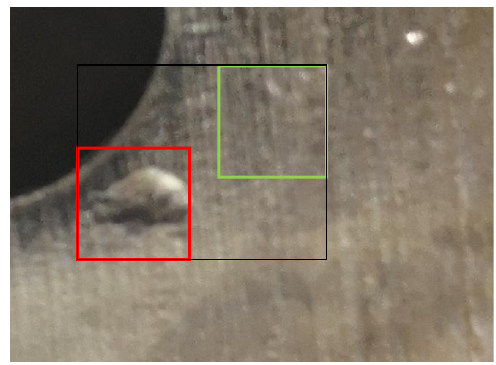
Figure 11. The smallest bounding rectangle C of GIoU .